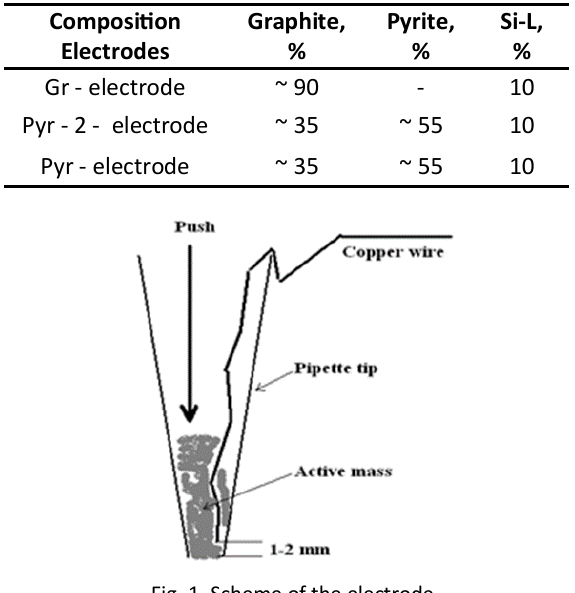
Table 1. Composition of mineral electrodes